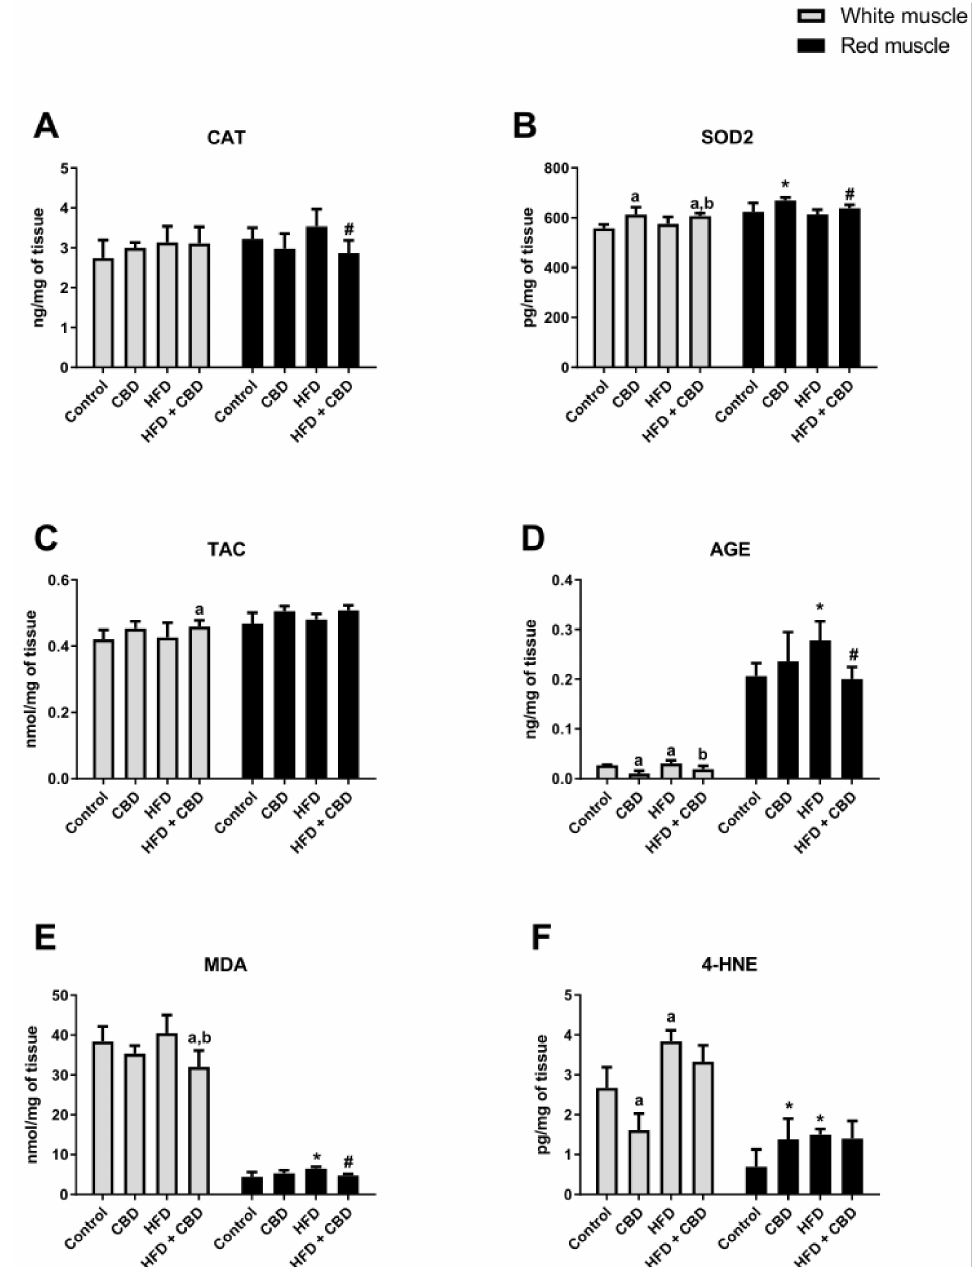
Figure 3. The effect of two-week cannabidiol (CBD) treatment on oxidative stress parame- ters, i.e., on ( A ) catalase (CAT), ( B ) superoxide dismutase 2 (SOD2), ( C ) total antioxidant ca- pacity (TAC), ( D ) advanced glycation end products (AGE), ( E ) malonyldialdehyde (MDA) and ( F ) 4-hydroxynonenal (4-HNE), in the white and red gastrocnemius muscles in the control (standard diet) and high-fat diet (HFD) groups. The data are expressed as mean values ± SD, n = 6 in each group. a p < 0.05 indicates a significant difference: the control group vs. the examined group in the white gastrocnemius muscle; b p < 0.05 indicates a significant difference: HFD vs. HFD + CBD in the white gastrocnemius muscle. * p < 0.05 indicates a significant difference: the control group vs. the examined group in the red gastrocnemius muscle; # p < 0.05 indicates a significant difference: HFD vs. HFD + CBD in the red gastrocnemius